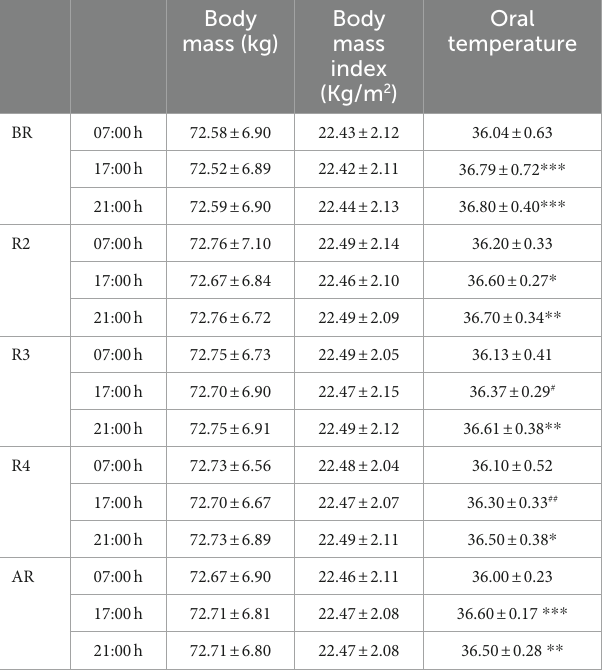
TABLE 1 Values (mean ± SD) of body mass, body mass index (BMI), and oral temperature recorded during the three times of the day (07:00, 17:00, and 21:00 h) 1 week before Ramadan (BR), during the 2nd week of Ramadan (R2), in the 3rd week of Ramadan (R3), during the 4th week of Ramadan (R4) and 2 weeks after Ramadan (AR; n = 11).